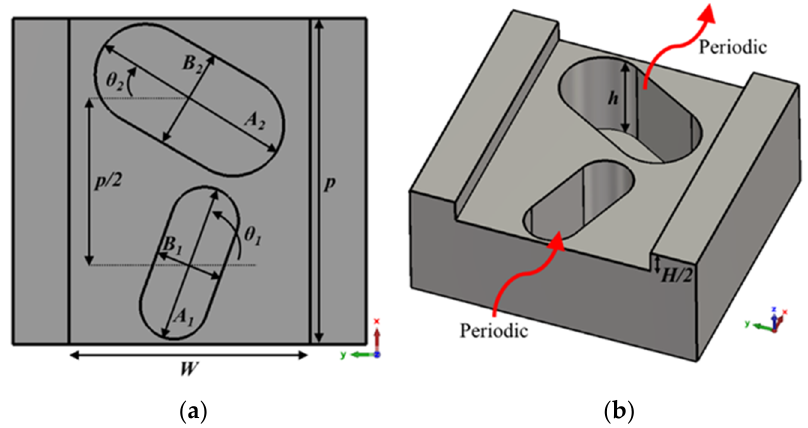
Figure 1. Bottom half of the generic ideal unit cell. ( a ) Top view and ( b ) perspective view. Periodic in x